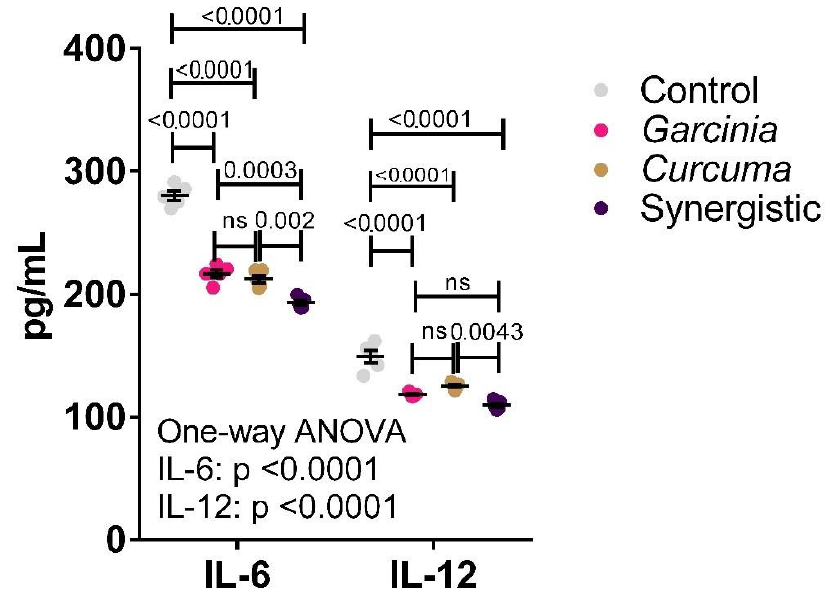
respectively. Moreover, 98.2% of the change in leptin is due to the changes in IL-6, IL-12, serotonin, and BW as markers of inflammation, brain chemistry, and obesity